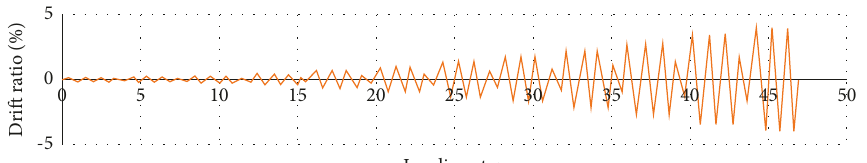
Figure 7: Lateral displacement history for cyclic loading at the top end of column